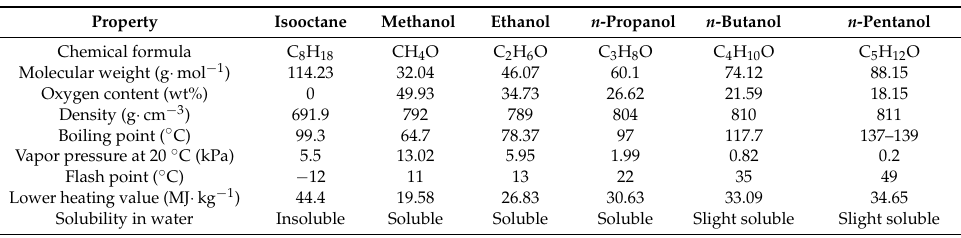
Table 1. Specifications of the fuels involved in this study